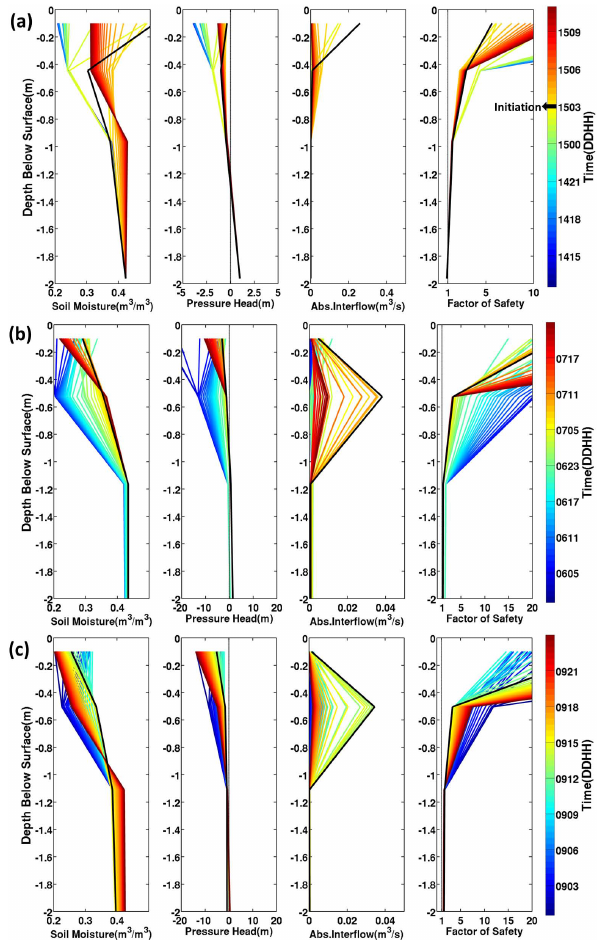
Fig. 13. Temporal evolution of the vertical profiles of soil moisture, pore pressure head, absolute interflow values and factor of safety at one of the debris flow initiation points in the basins in the event in July of 2011 (a) , and in January (b) and December (c) of 2009. Color scheme indicates